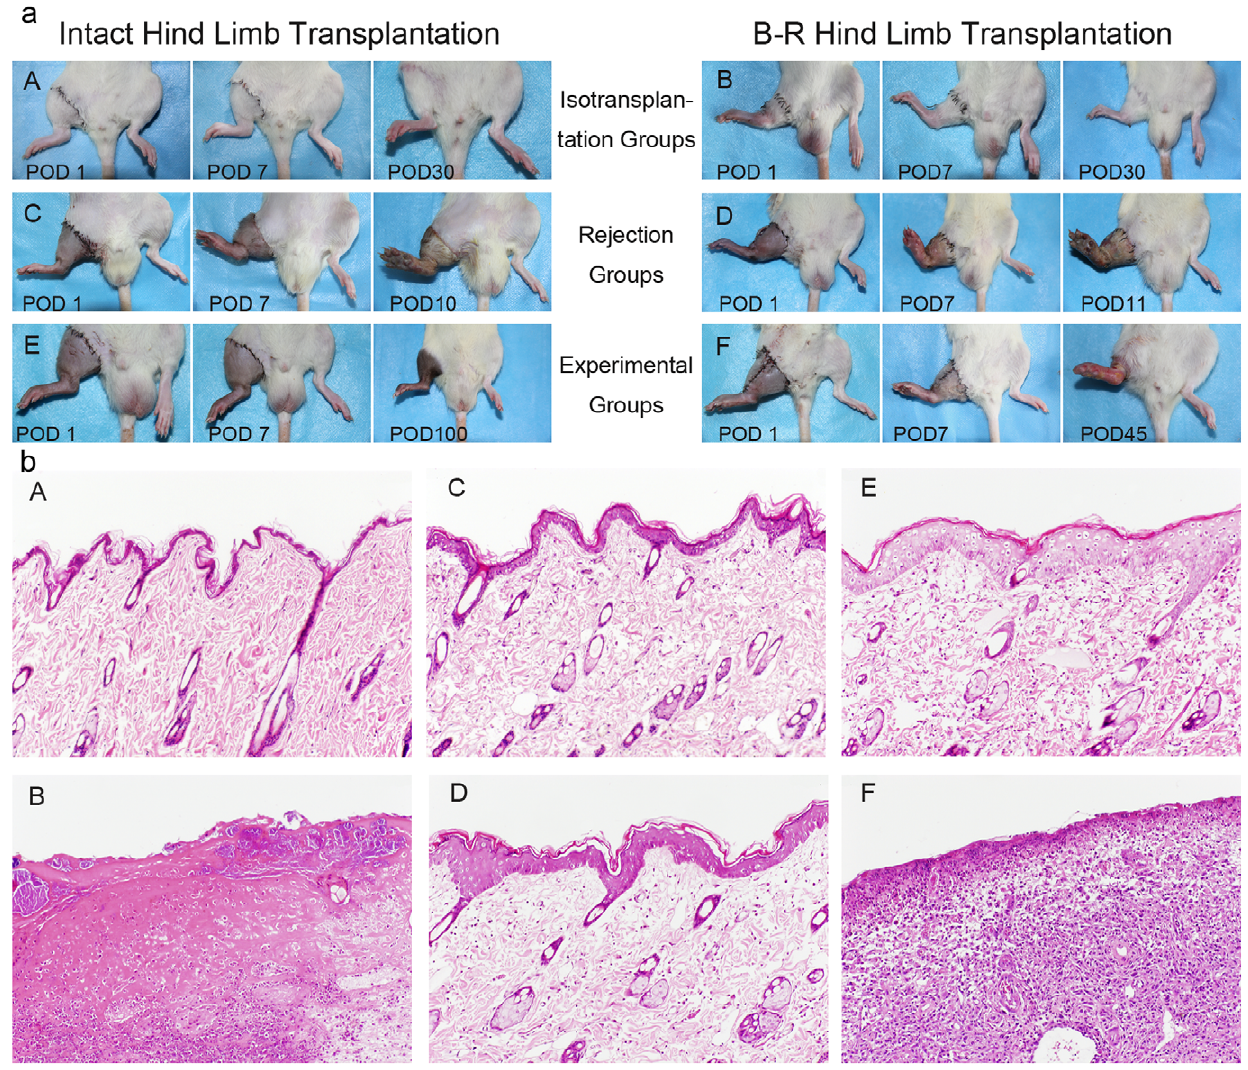
Figure 1. Evaluation of tissue viability and pathological changes of transplanted grafts. (a-A, B): Isografts in groups 1 and 2 survived well. (a-C, D): Allografts in groups 3 and 4 that received N.S showed obvious rejection profiles at 10–12 days postoperatively. (a-E): Allografts in group 5 survived rejection-freely for up to 100 days. With the same CsA protocol, the B–R hind limbs in group 6 were all rejected within 2 months (a-F). (b-A): Skin histologic sections from isograft groups showed normal epidermis and dermis. (b-B): Skin histologic sections from rejection control groups showed necrotic epidermis features of grade 3 rejection reaction at POD 11. (b-C, D): Skin biopsies from CsA treatment groups 5 and 6 at POD 30 showed grade 1 rejection reaction with focal epidermal mononuclear cell infiltration, respectively. (b-E): At POD 100, skin biopsies from recipients in group 5 showed grade 1 rejection and a mild increase in the number of lymphocytes infiltrating the upper dermis at POD 100. (b-F): Skin biopsy from group 6 when the allograft was rejected showed necrotic features of grade 3 rejection reaction in the epidermis and a marked increase in the number of lymphocytes infiltrating all tissues from the dermis down to the muscles (H&E, 6 20). doi:10.1371/journal.pone.0043825.g001 Tregs in the peripheral blood in groups 5 and 6 at POD 30 were both at the background levels obtained from the naı¨ve LEW rats (data not shown). At POD 100, the proportion of Foxp3 + Tregs increased in both the peripheral blood and the spleens of recipient rats in group 5, with a high degree of FoxP3 mRNA expression in the allografts (Figs. 6b, 6c). However, when the grafts were rejected in group 6, Foxp3 + Tregs observed in either the peripheral blood or spleen, and Foxp3 mRNA expressions in the allografts were not significantly different from the background level. These increased levels of Foxp3 + Tregs in group 5 were further found to be donor- specific (Fig. 6a).